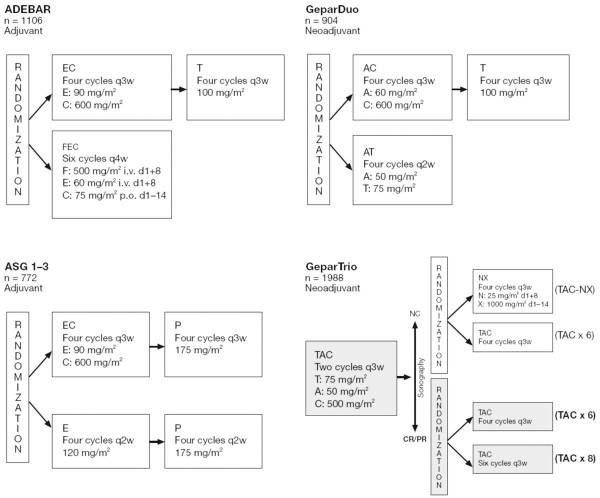
Study design of the four trials. CR, complete response; PR, partial response; NC, no clinical response. EC-T, epirubicin, cyclophosphamide followed by docetaxel; FEC, 5-fluorouracil, epirubicin, cyclophosphamide; EC-P, epirubicin, cyclophosphamide followed by paclitaxel; AC-T, doxorubicin, cyclophosphamide followed by docetaxel; E-P, epirubicin followed by paclitaxel; AT, doxorubicin, docetaxel; TAC, docetaxel, doxorubicin, cyclophosphamide; NX, vinorelbine, capecitabine. q2W, every 2 weeks; q3W, every 3 weeks; q4W, every 4 weeks. i.v., intravenously; p.o., per orally; d, day.